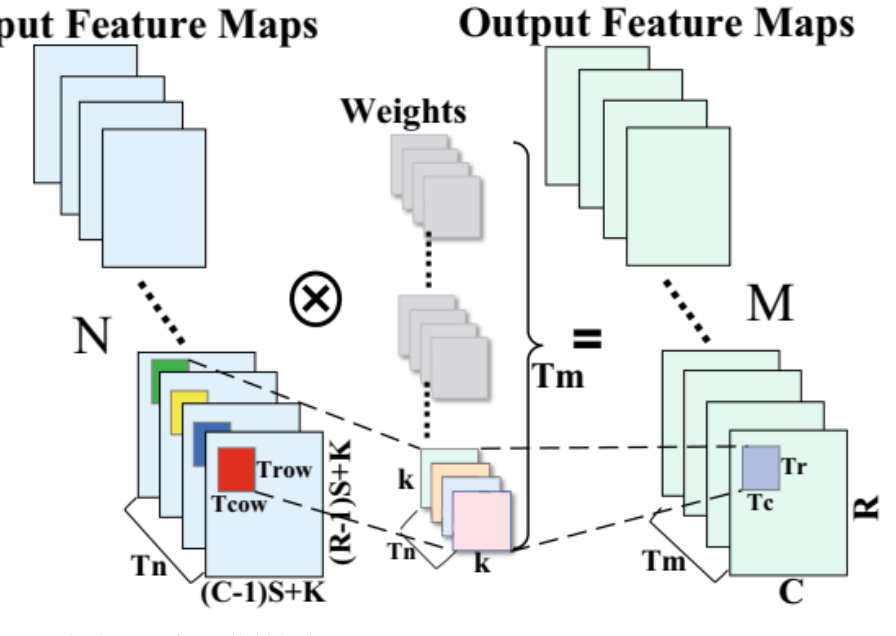
Figure 8. Calculation of parallel block.